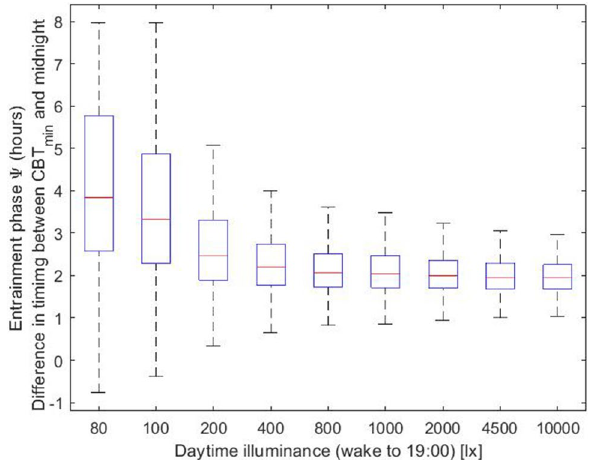
Figure 2. Entrainment phase angle distribution for a population of 200 simulated individuals with a normally distributed intrinsic circadian period with means (± SD) of 24.15 (± 0.2) h 33 . Illuminances refer to corneal light exposure (i.e., at the eye) for daytime (wake-19:00) illuminance (L 1 ) set to the values indicated on the x-axis. Evening light exposure L 2 was simulated at 30 lx from 19:00 until sleep onset. The central marker indicates the median, and the bottom and top edges indicate the 25th and 75th percentiles, respectively. The whiskers extend to the most extreme data points (population minima and